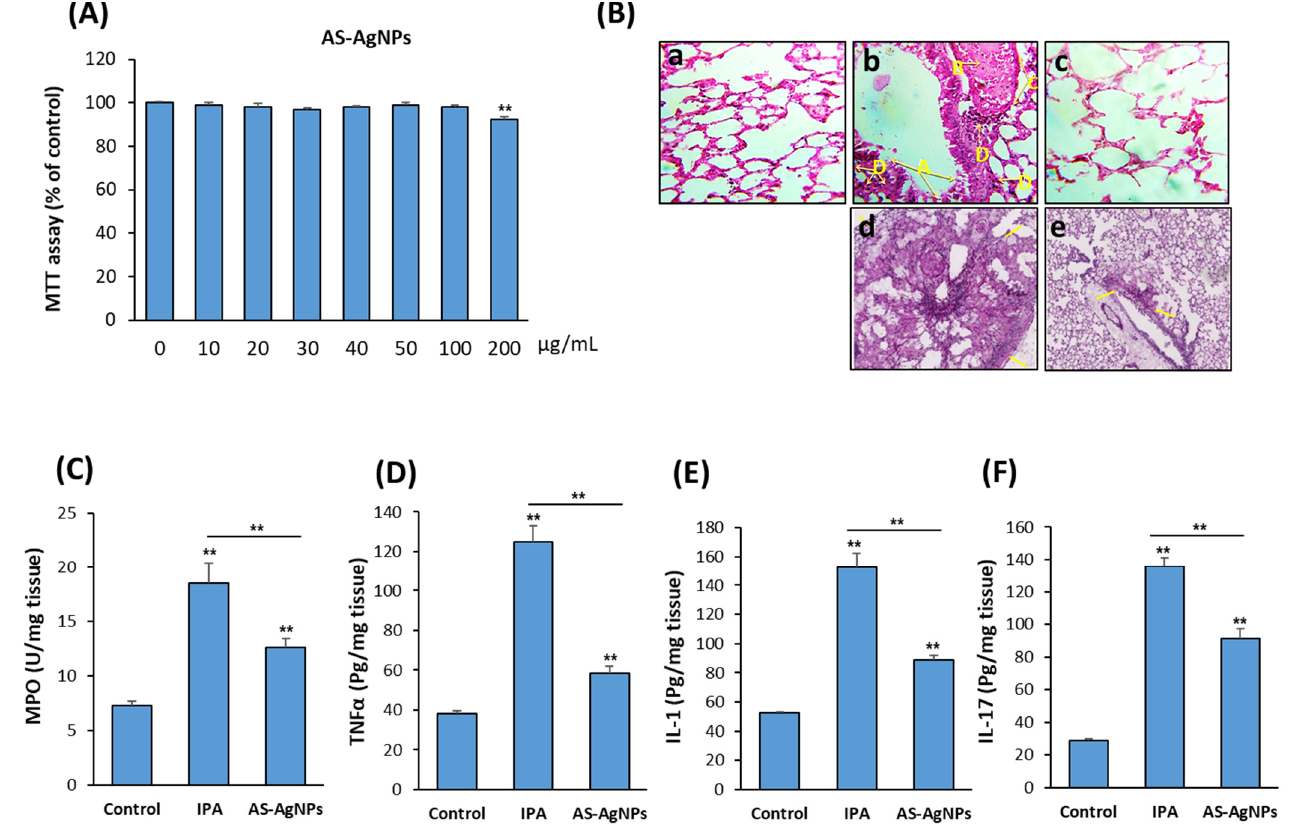
Figure 5. Cytotoxicity of AS-AgNPs on the human lung cancer cell line, A549. ( A ) The dose-dependent effect of AS-AgNPs on the cell viability of human A549 cells was measured by MTT assay after 48 h of treatment. Values are shown as the mean ± SD of three independent experiments. ( B ) Histological sections of lung tissue stained with ( a – c ) H&E and ( d , e ) periodic acid Shiff (PAS) from 3-day post-AS-AgNP instillation. ( a ) Control mice (HBSS), ( b , d ) IPA mice, and ( c , e ) IPA mice treated with AS-AgNPs. Arrows in ( b ) specify the following: A; degeneration and desquamation of the lining of the respiratory epithelium of the bronchiole; B, dilatation and congestion of blood vessels; C, thickening in the wall of blood vessels; and D, lymphocytic infiltration in tissue. Arrows in ( d ) and ( e ) specify the boundaries of fungal lesions. Measurements of inflammatory cytokines ( C ) MPO, ( D ) TNF- α , ( E ) IL-1, and ( F ) IL-17 at 3 days post-instillation of IPA mice with HBSS or AS-AgNPs. Data are expressed as the means ± SD ( n = 8 mice/group). * p < 0.05 and ** p < 0.005 compared to control, non-treated mice.